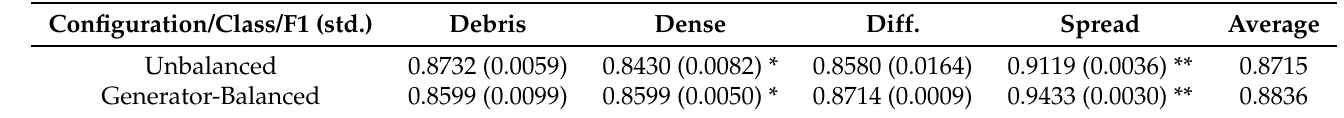
Table 12. F1-score for unbalanced and generator-balanced temporal training configurations show an overall improvement for the balanced configuration on average, as well as statistically significant increases in the dense and spread classes. The p -value indicated by the * is calculated using Student’s t